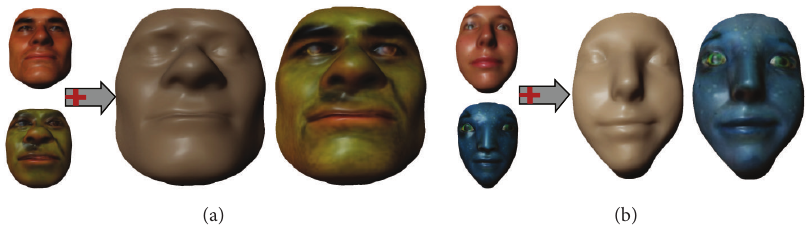
Figure 1: The proposed approach can automatically transfer the human identity of a human face to a provided 3D artistic face while providing a simple high-level control to users.